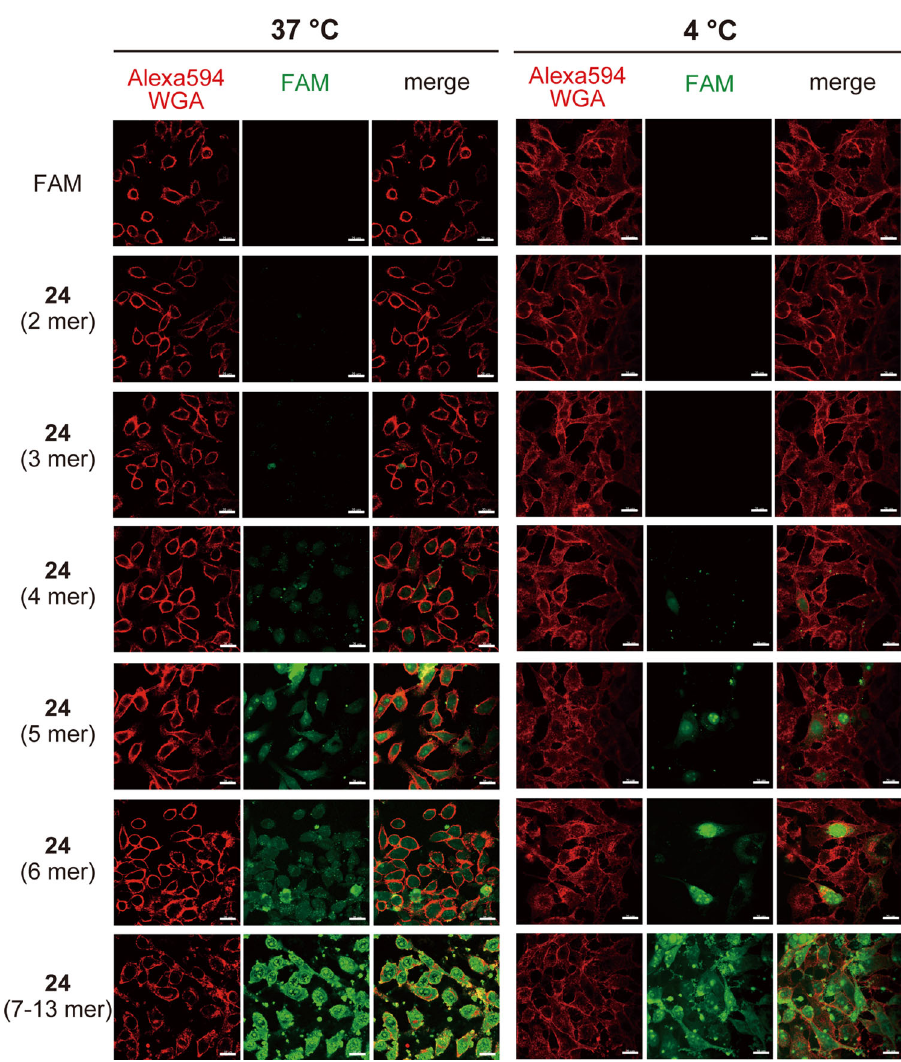
Fig. 7 Cell-penetrating activity of ε -O β L. HeLa cells were incubated with 50 µ M of ε -O β L m -FAM ( 24 ) (2 mer), 24 (3 mer), 24 (4 mer), 24 (5 mer), 24 (6 mer), or 24 (7 – 13 mer) for 60 min at 37 °C or 4 °C under a typical cell culture condition with serum. After washing and fi xing the cells, the cellular localization (green) of 24 was determined by CM. The cell membrane was stained with Alexa594-WGA (red). The representative CM images are shown. Scale bars, 20 µ